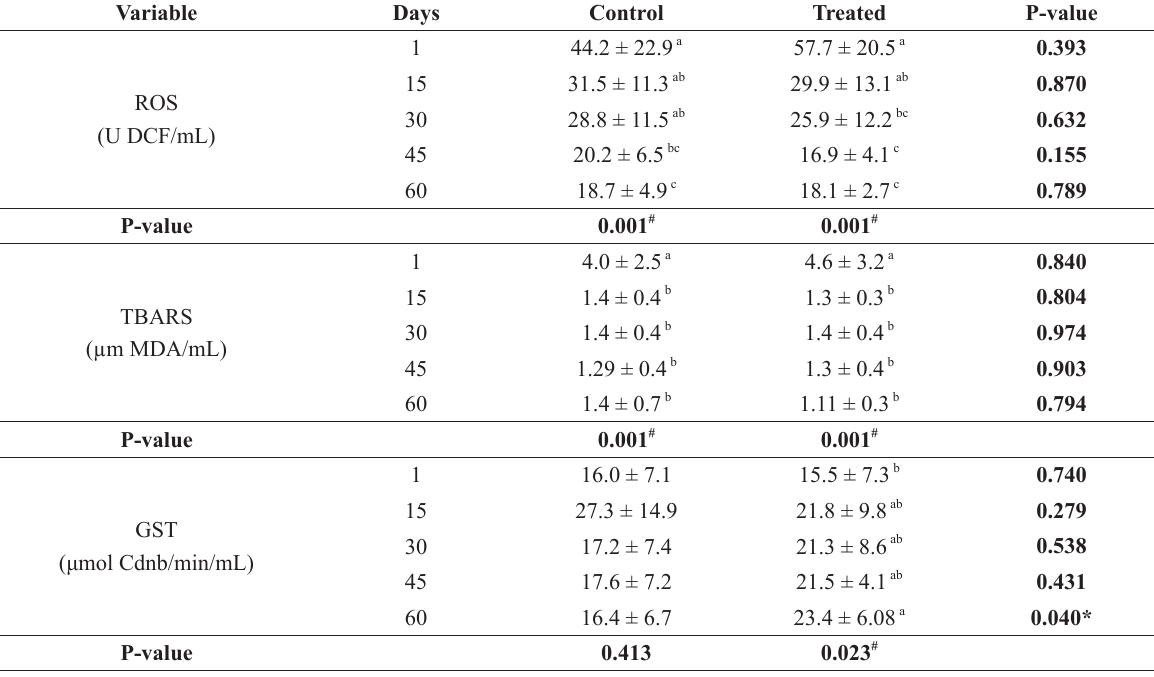
Levels of reactive oxygen species (ROS), and thiobarbituric reactive acid substances (TBARS), and gluthatione S-transferase (GST) activity in serum of calves from control and treated